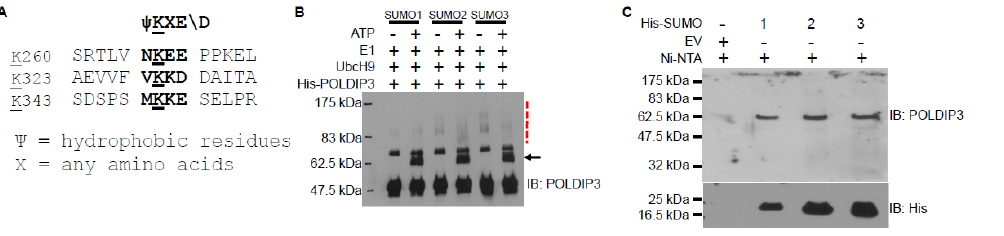
Figure 4. POLDIP3 can be sumoylated both in vitro and in vivo. ( A ) The SUMO consensus sequences in human POLDIP3 protein. ( B ) In vitro sumoylation assay. Purified recombinant proteins were used in the in vitro sumoylation assay in the presence (+) or absence ( − ) of ATP. The black arrow indicates the mono-sumoylated POLDIP3. The dashed red line marks the poly-sumoylated POLDIP3. ( C ) In vivo sumoylation assay. HEK293T cells were transfected with either empty vector (EV) or plasmids expression His-SUMO-1, or His-SUMO-2, or His-SUMO-3. Ni-NTA beads were used to pull-down the sumoylated proteins, which were then immunoblotted (IB) with antibodies as indicated on the right. Table 1. Modifications of POLDIP3.